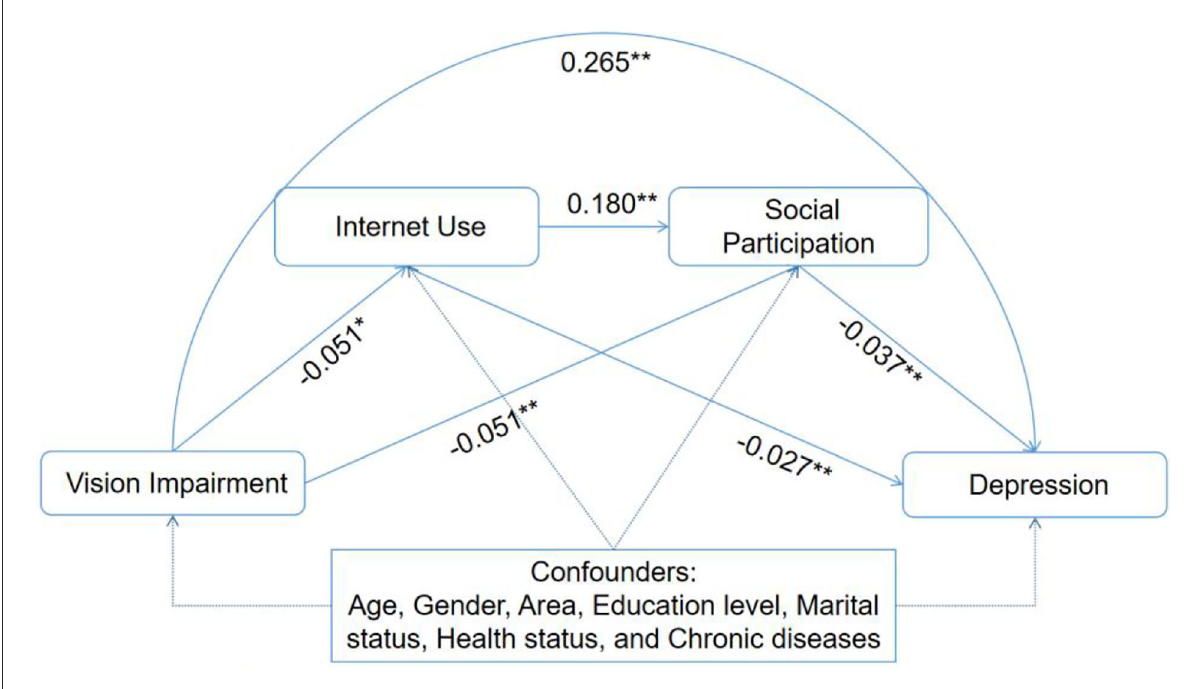
FIGURE1 Statistical model of chain-mediating